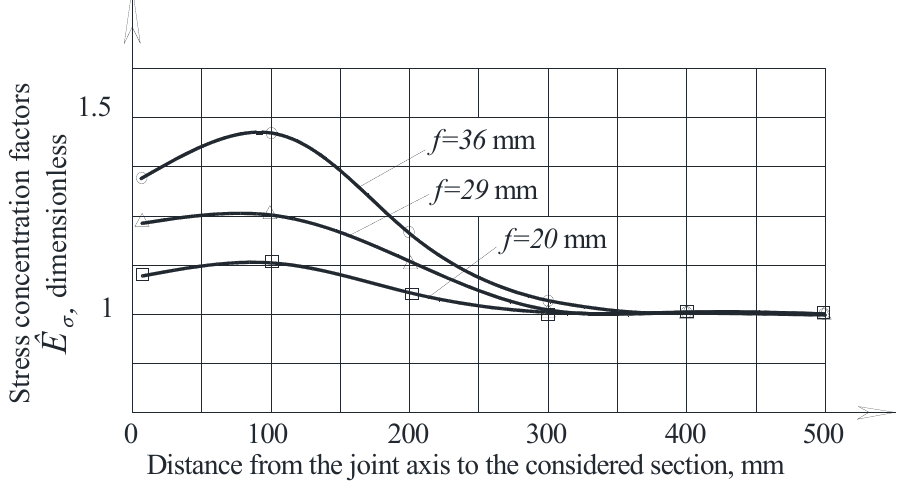
Figure 14. Stress concentration in the operated full-scale tank wall field joint zone with bend: 我 f = (cid:35) 20 mm; 你 f = 29 mm; ○ f = 36 mm.